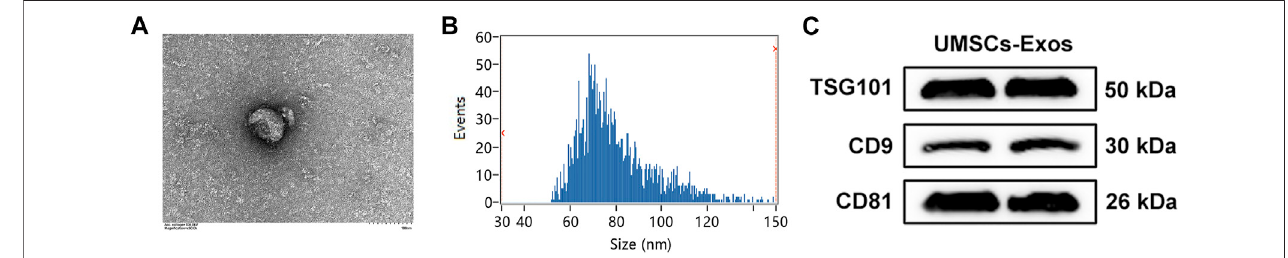
FIGURE3| Identi fi cationofHUC-Exos(exosomessecretedbyHUCMSCs). (A) Representativepictureoftheultrastructureofexosomesobservedbytransmission electronmicroscopy(TEM). (B) Theaverageparticlesizedistributionofnormal-Exosanddiabetes-Exoswasmeasuredbydynamiclightscattering(DLS). (C) Themarker protein levels of CD9, CD81, and TSG101 in the isolated exosomes were detected withWesternblotting. Differences were measured by one-way ANOVA followed bya Tukey post hoc test for pairwise comparison. Data presented as means ± SD. **** p < 0.0001, *** p < 0.001, ** p < 0.01, and * p < 0.05.